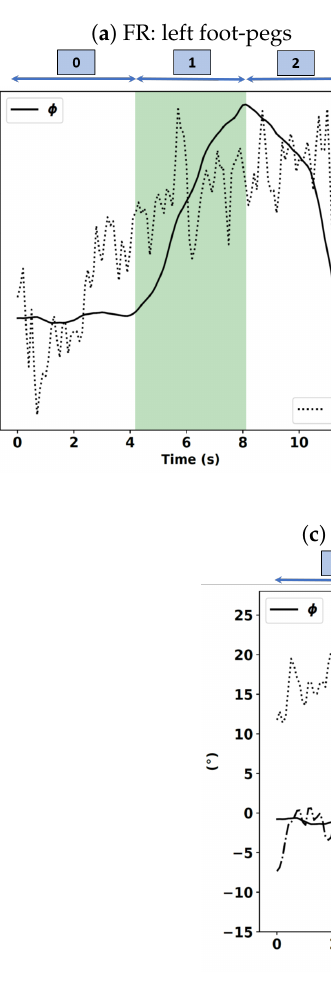
Figure 13. Left and right foot-pegs ( Fl f − p , Fr f − p ), buttocks forces ( FlB , FrB ) expressed in newtons (N) with the roll angle ( φ ) expressed in degrees (°) in the FR